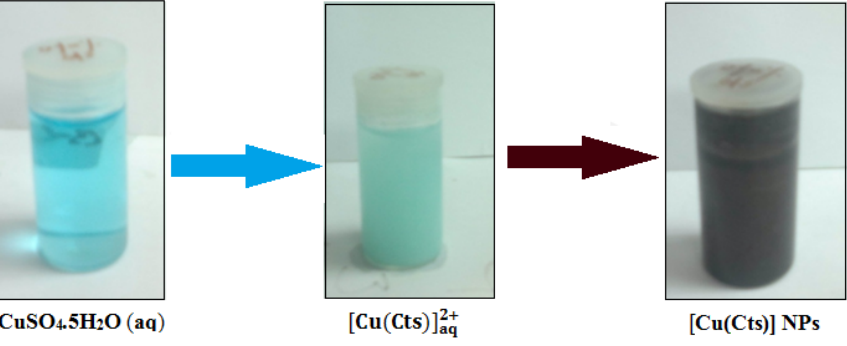
Figure 1. Photographs of the sample at the different stages of synthesis showing colour